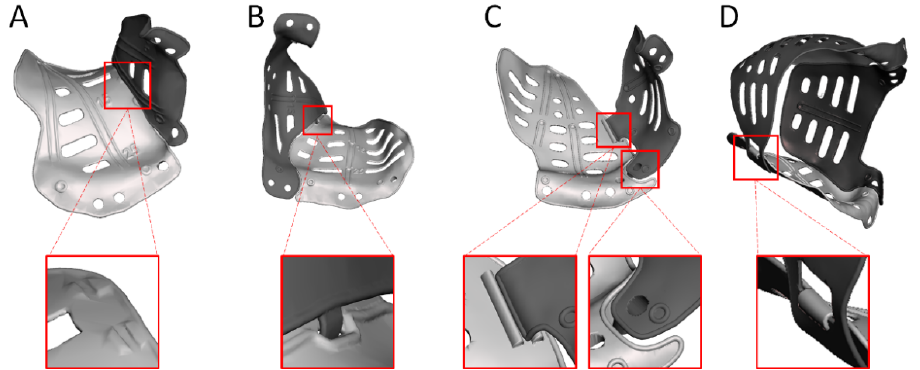
Figure 6. Patient-specific implant design for multi-wall cases. ( A ) Ridges on the orbital floor implant provide relative feedback for the positioning of the lateral wall implant. ( B ) Patrix–matrix connection to connect a medial wall and orbital floor implant. ( C ) The orbital floor implant with medial wall extension is connected to a lateral wall implant dorsally with ridges and anteriorly with a puzzle connection. ( D ) Four-wall reconstruction with a hook-and-bar connection for additional support for the orbital floor implant.